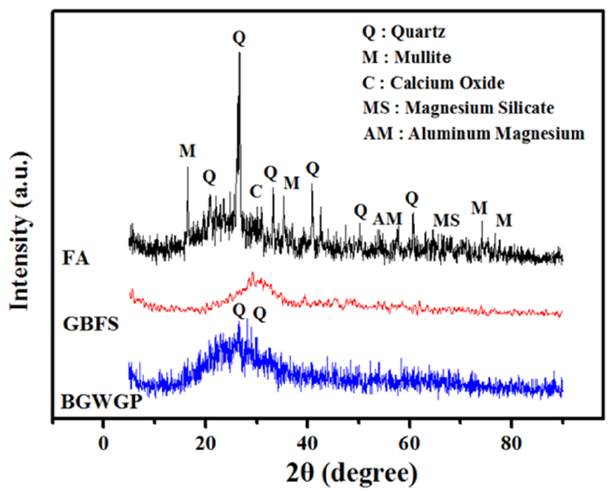
Figure 2. XRD patterns of FA, GBFS, and BGWNP.